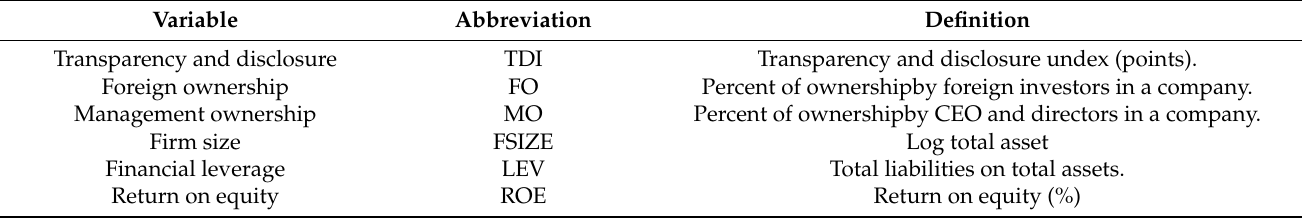
Table 1. Definitions of independent variables used in the